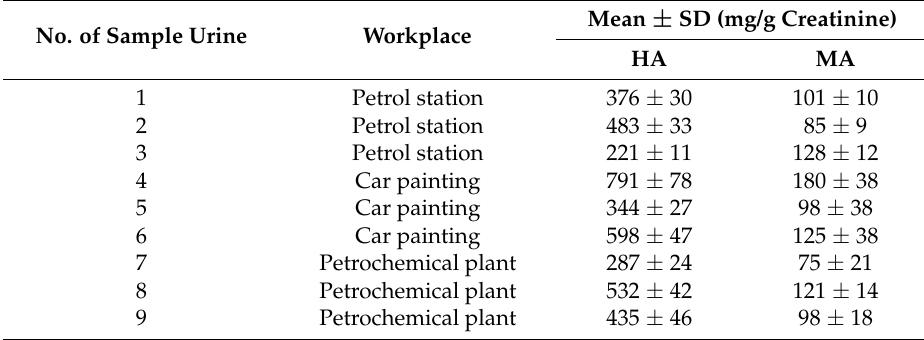
Table 3. Concentrations of toluene and ethylbenzene metabolites detected in human urine of exposed workers.